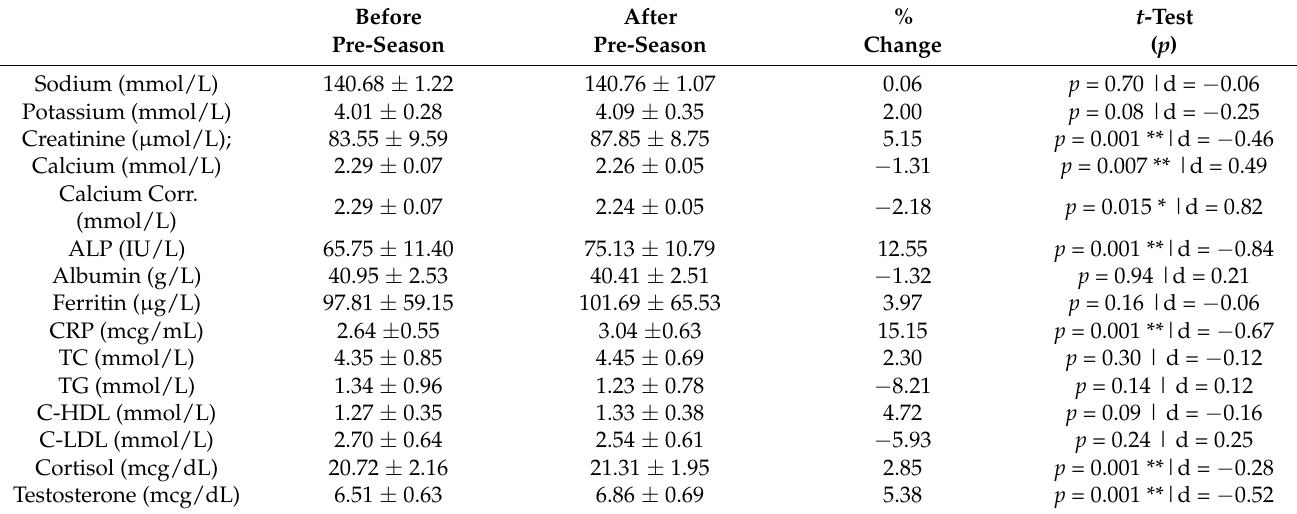
Table 2. Before and after pre-season data (mean ± SD) of biochemical parameters (BcP). Before